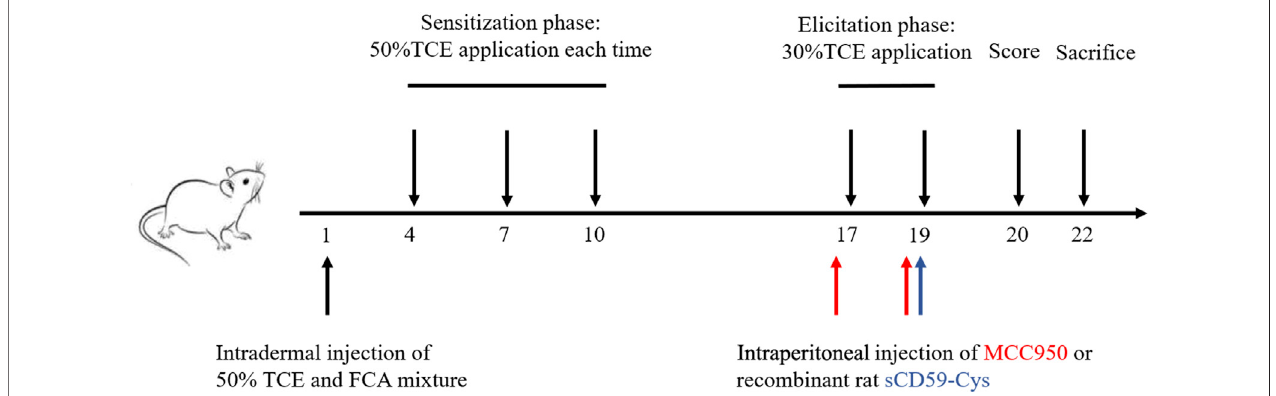
FIGURE 1 | Flow diagram of the skin-sensitized mouse model by TCE. Note: 50% TCE (TCE: olive oil: acetone = 5:2:3); 30% TCE (TCE: olive oil: acetone = 3:2:5). sCD59-cys, a speci fi c inhibitor of C5b-9 assembly; MCC950, a speci fi c antagonist of NLRP3.